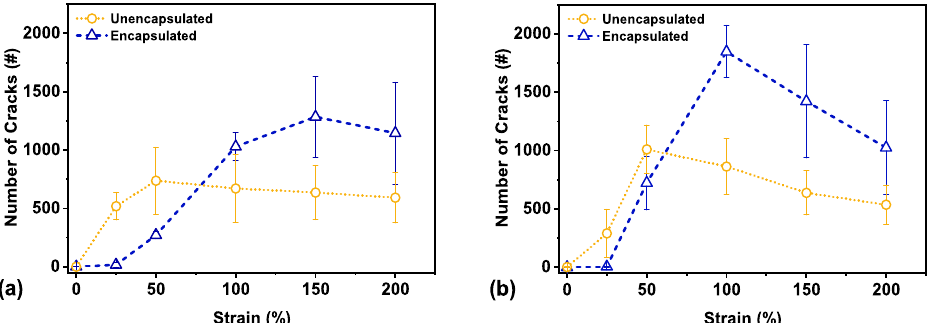
Figure 6. ( a ) Pre-fracture crack number for unencapsulated and encapsulated sensors, N = 3 each, and ( b ) post-fracture crack number for unencapsulated and encapsulated sensors, N = 3 each. Error bars depict standard deviation across all images. Number of cracks serve as a proxy for crack density.